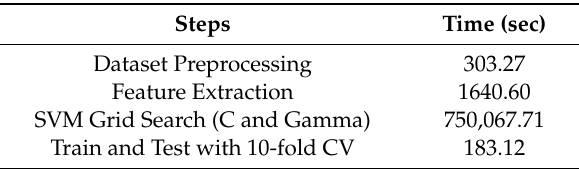
Table 3. The execution time of our proposed